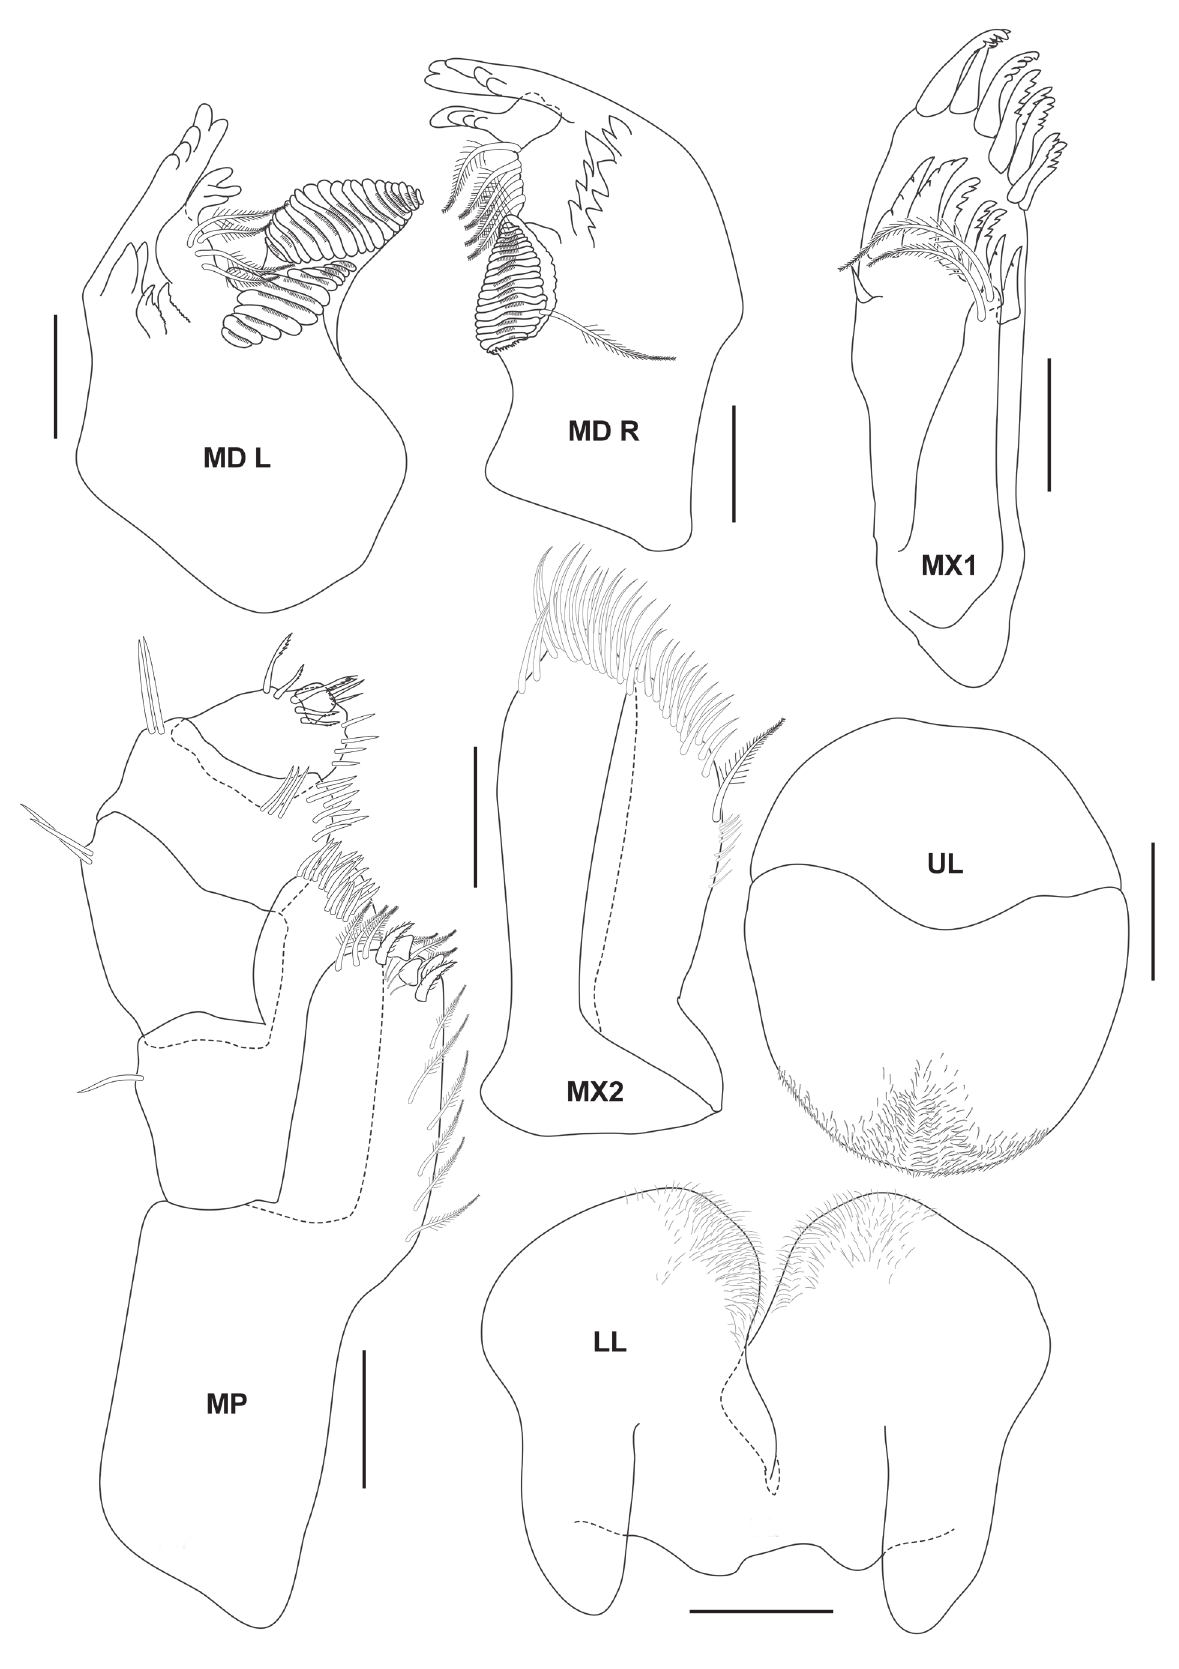
Figure 9. Floresorchestia samroiyodensis sp. n., allotype, male, (PSUZC-CR-0274) 10.5 mm. Khao Sam Roi Yod National Park. Scales for lMD, rMD and UL represent 0.1 mm; MP and MX1 represent 0.2